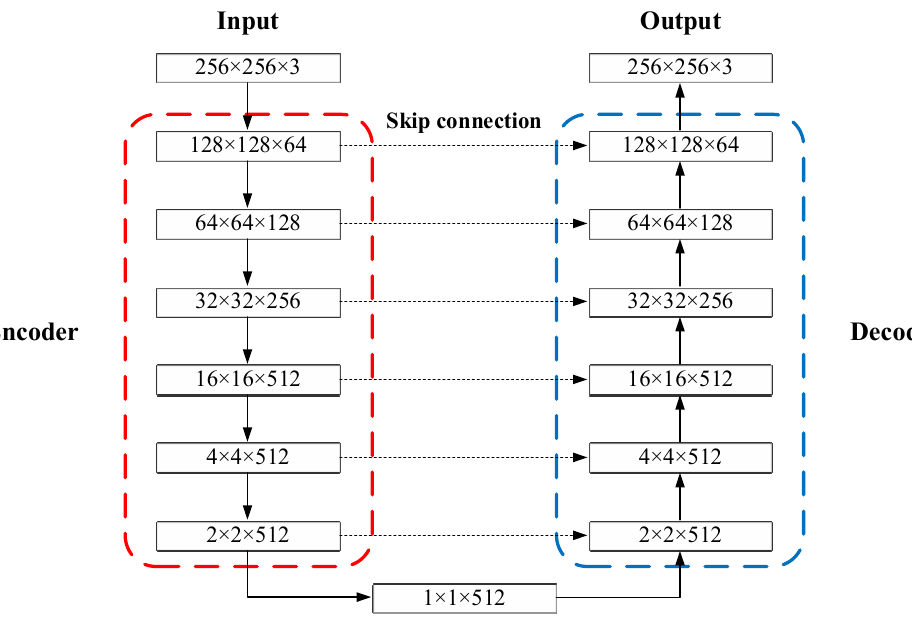
Figure 6. Feature map size changes in the generator network.